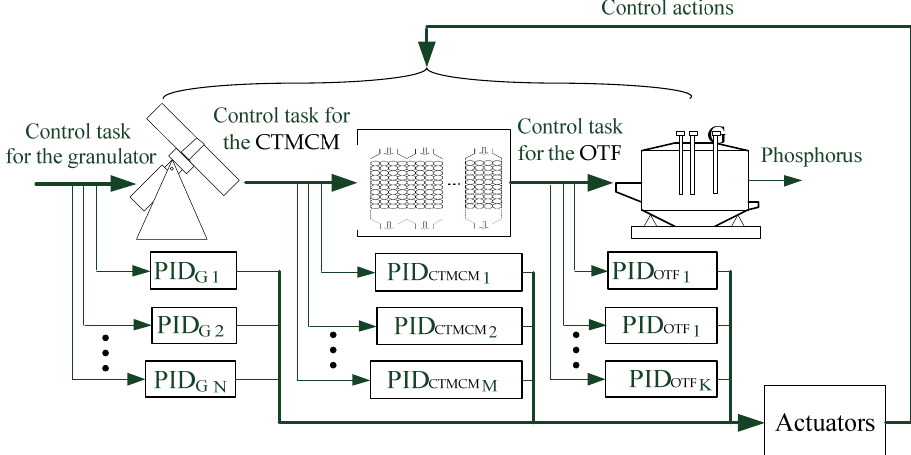
Figure 2. The structure of the CETS control system at the level of controllers.